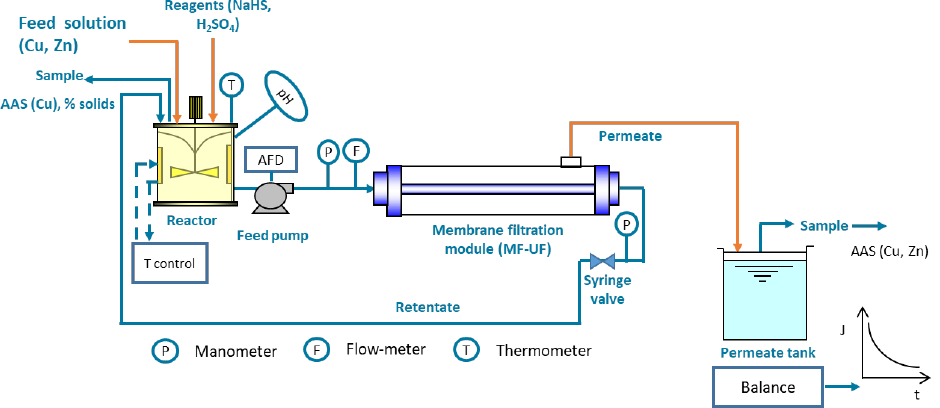
Figure 9. Membrane filtration prototype at a laboratory scale applied to assess metal sulfide precipitates in cyanide media and AMD. Adapted from [53].